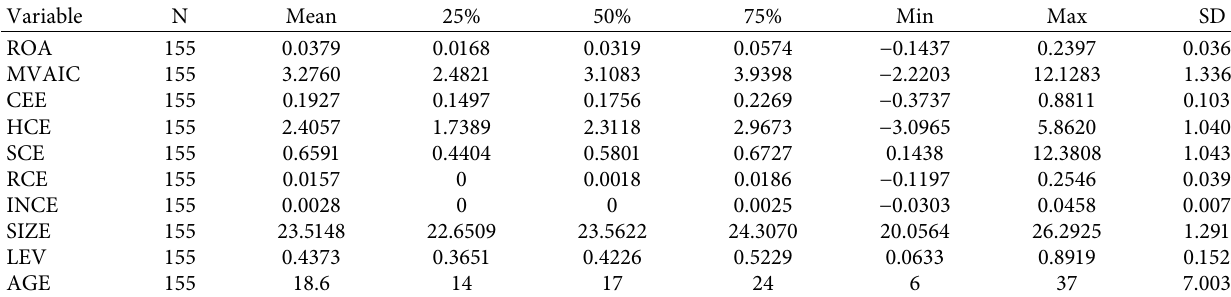
Table 1: Descriptive statistics.